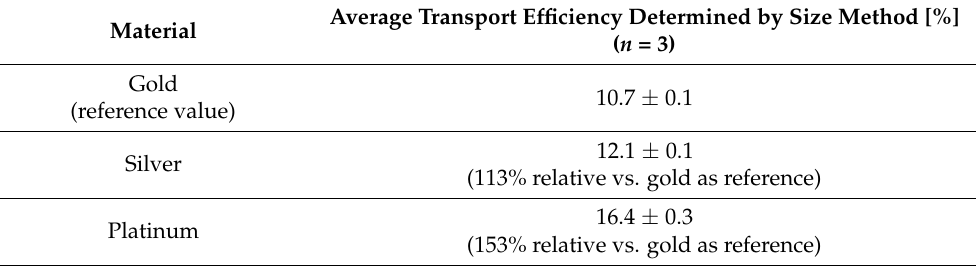
Table 8. Transport efficiencies obtained using three types of nanoparticles.